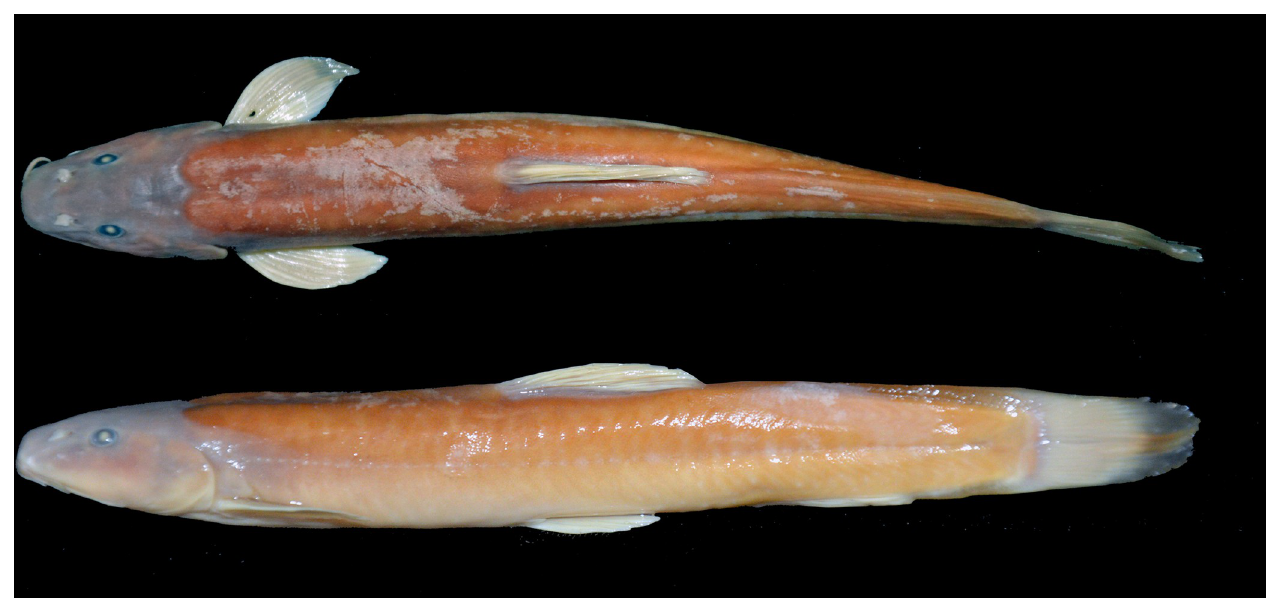
Fig 6. Left lateral and dorsal views of Homatula longibarbatus , holotype SWFU 0309082, 107.3 mm SL; China: Yunnan Prov.: Dali Pref.: Yangbi Co.: Pingpo